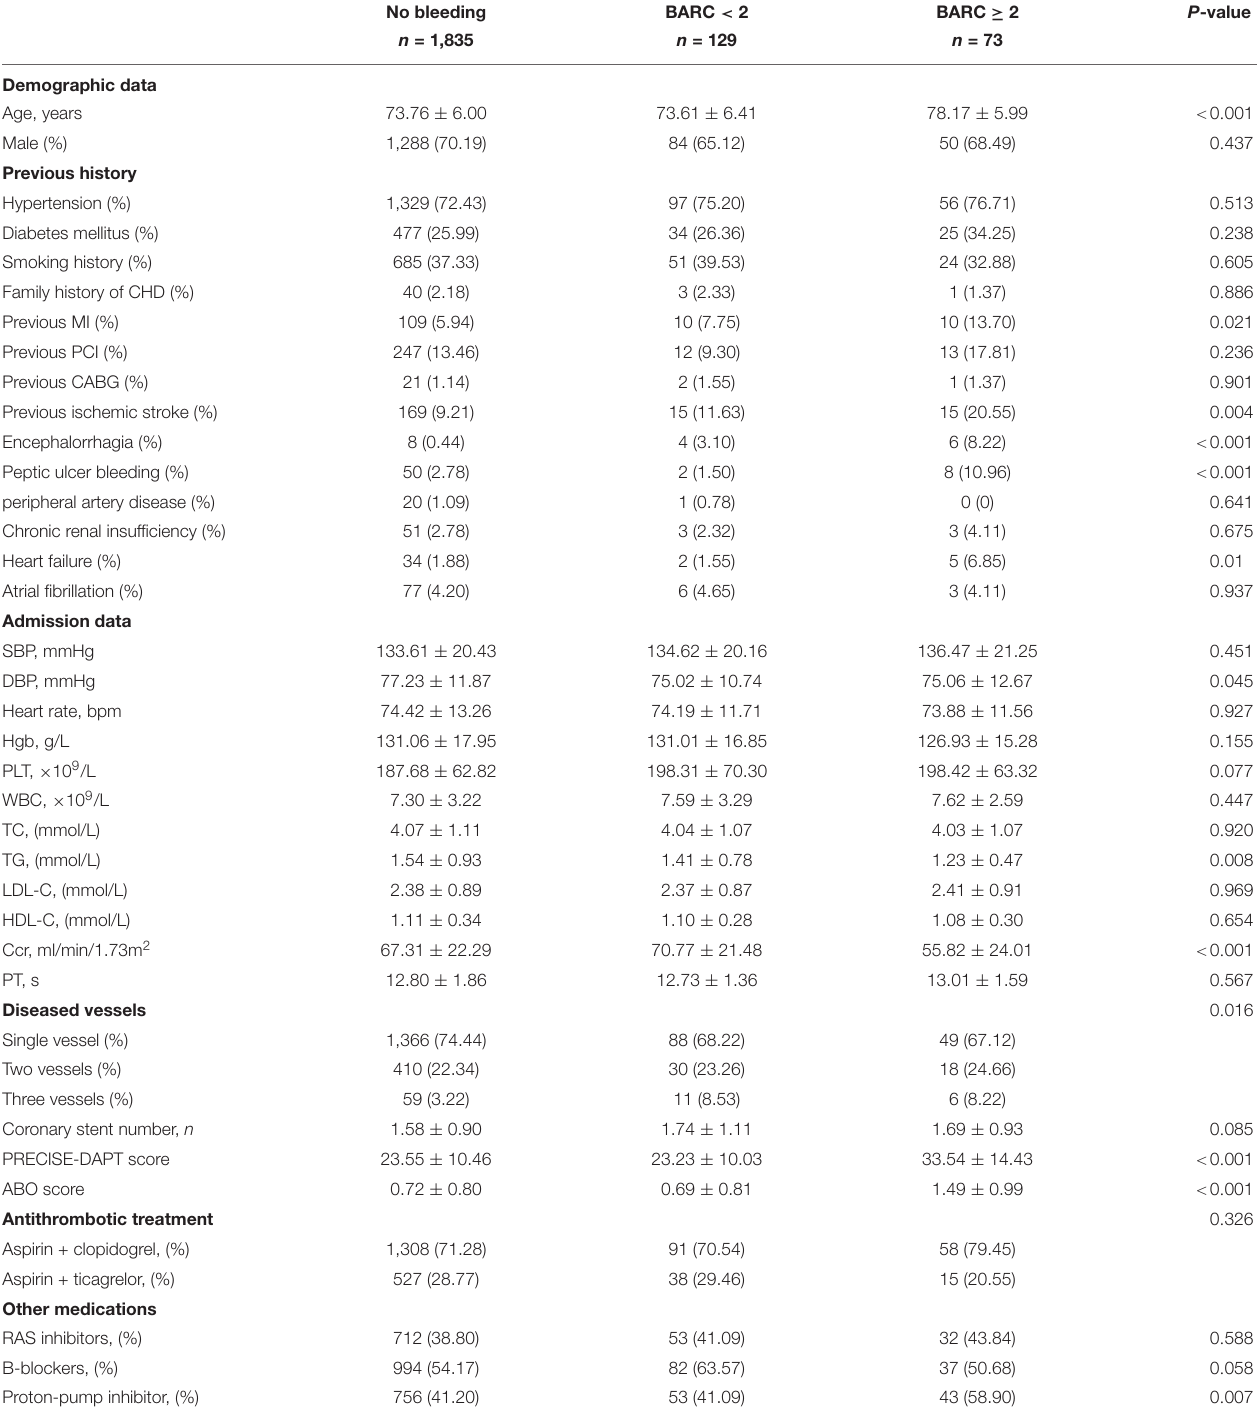
TABLE 1 | Baseline clinical characteristics and in-hospital management of study